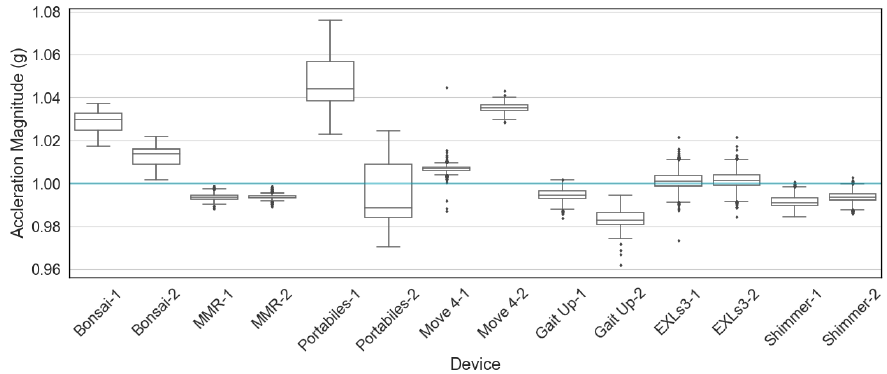
Figure 5. Accelerometer baselines. Acceleration at 1 g (gravity) marked by a turquoise line.